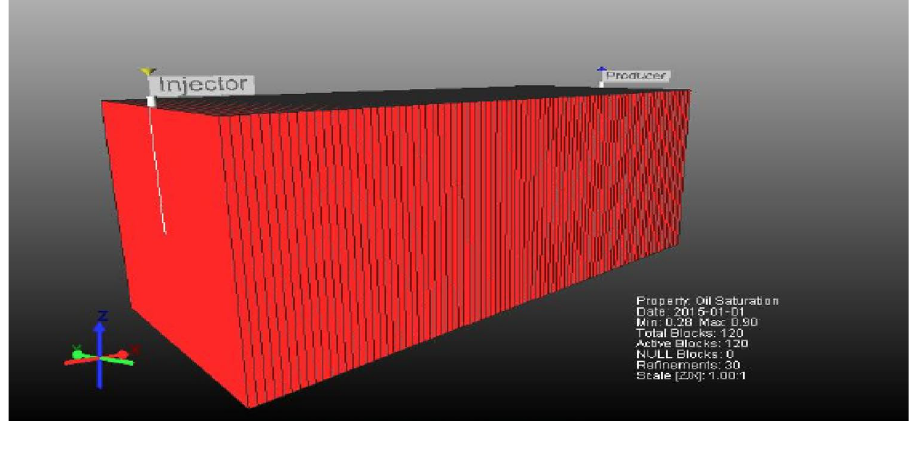
properties of the experimental and model core